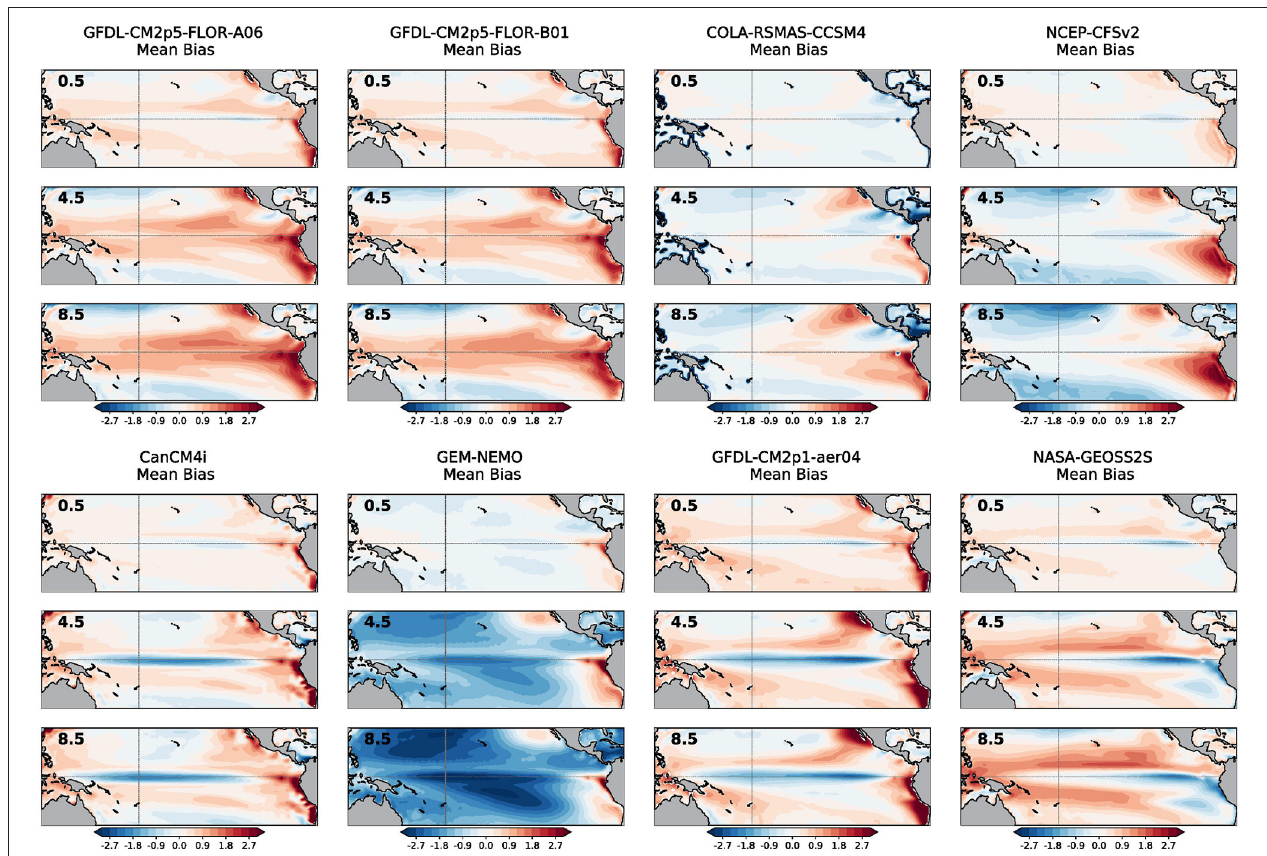
FIGURE 4 | As in Figure 2 except showing the mean bias (forecast mean minus observed mean) in monthly sea surface temperatures over January 1982 to December 2020. Units are in degrees Celsius.